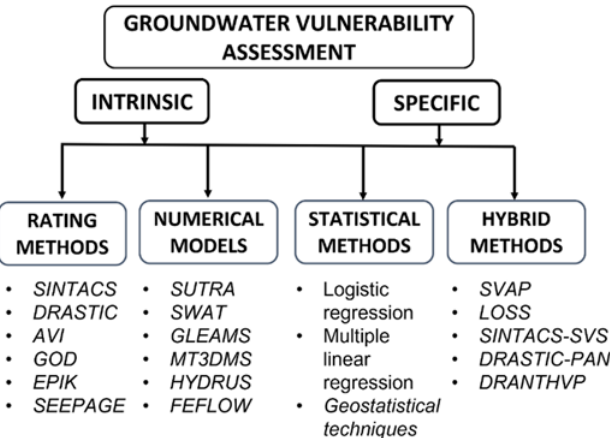
Figure 2. Conceptual organization of this review.